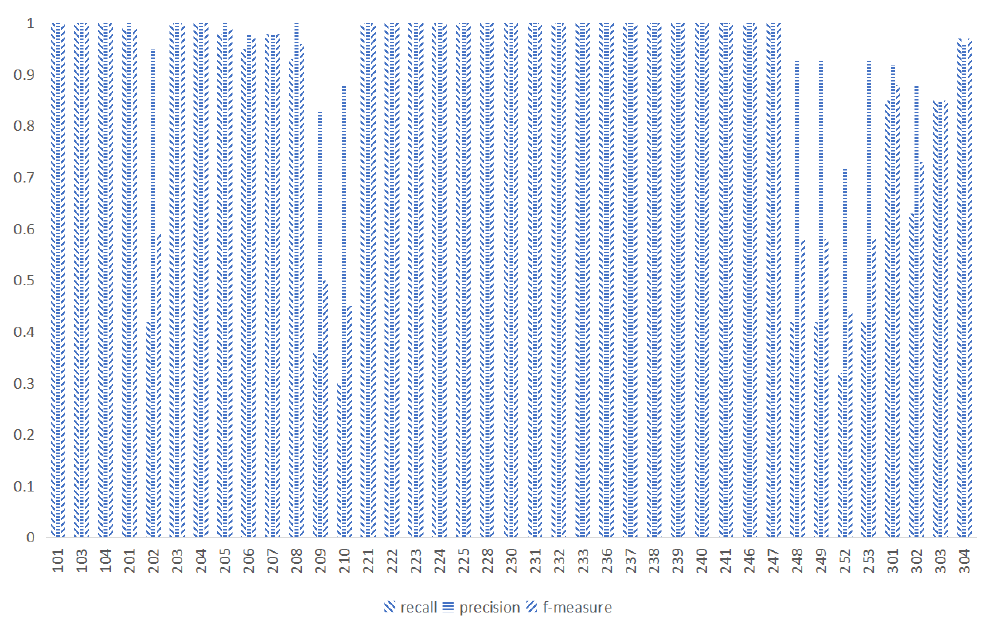
Figure 7. The Testing Results of Our Approach on OAEI’s Benchmark.